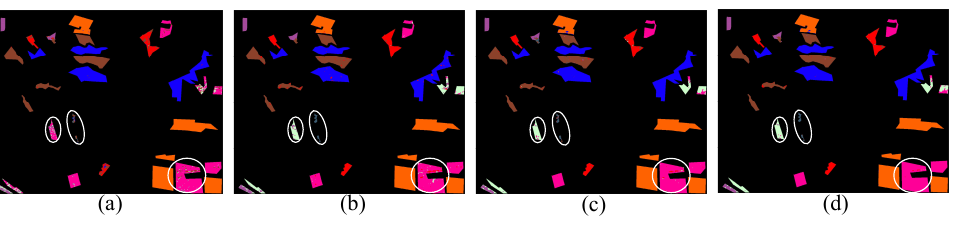
Figure 24. Classification maps of GF-3 dataset with different classification methods. ( a ) Dense- CapsNet. ( b ) Res-CapsNet. ( c ) CNN-CapsNet. ( d ) Proposed HCapsNet (without